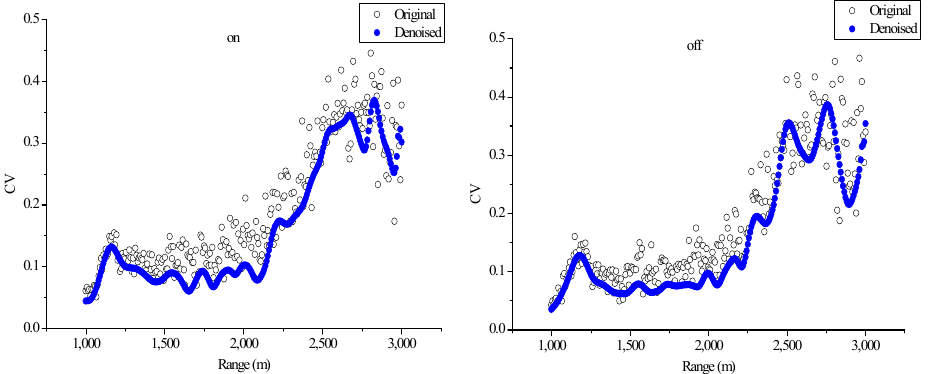
Figure 16. CVs of original signals and denoised signals via LWT (( left ) on ‐ line wavelength; ( right ) off ‐ line wavelength).